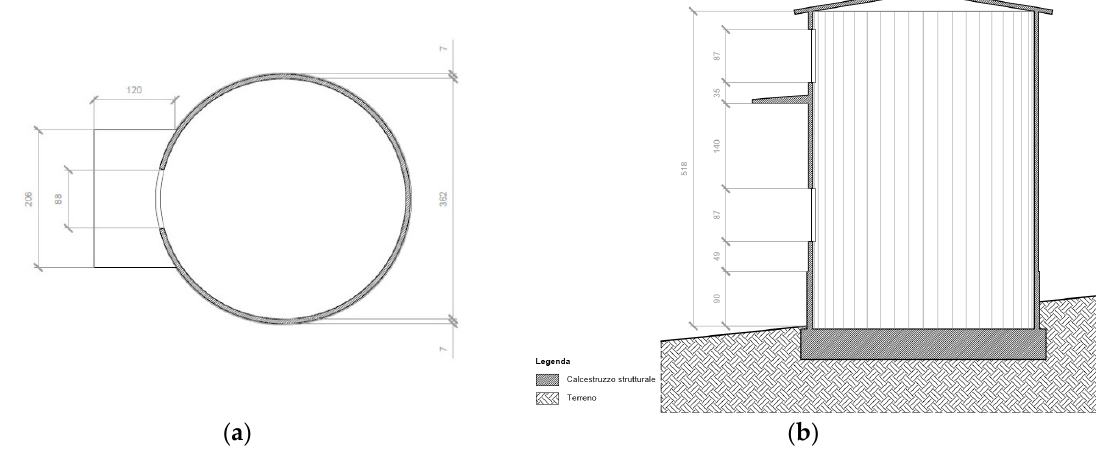
Figure 3. Pictures of the silos reported in the previous orthophoto of Sant’Apollinare area. ( a ) Silo Le